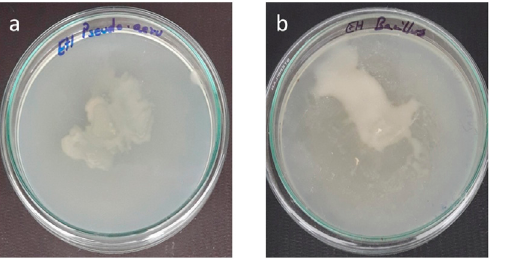
Fig. 7. Protein leakage assay of crude silver nanoparticles against Pseudomonas aeruginosa and b) Bacillus subtilis